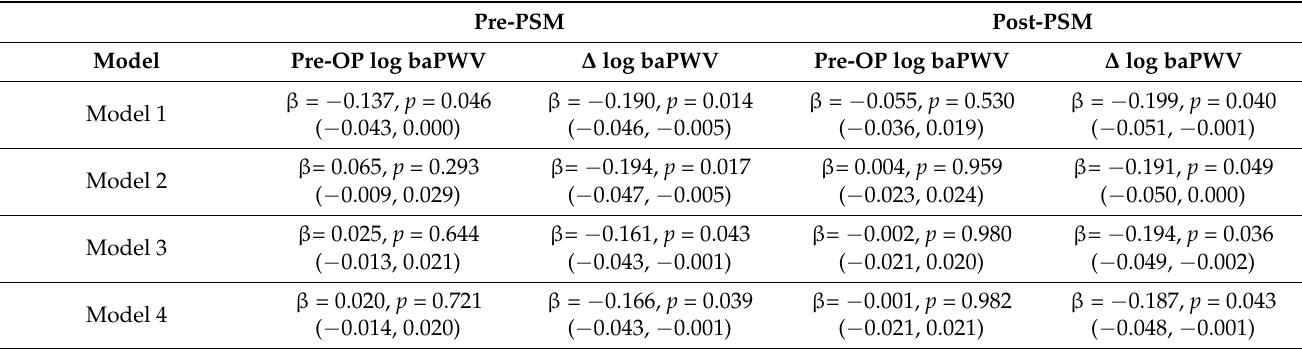
Table 5. Correlation of KCNJ5 mutations with baseline log baPWV and the change of log baPWV after adrenalectomy of APA patients before and after